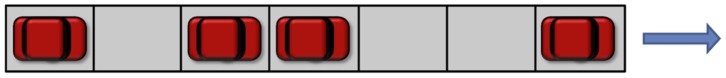
Road setup.The road is represented by a periodic boundary 1D lattice divided into L = 200 cells. Each cell is either empty or occupied by a single car.